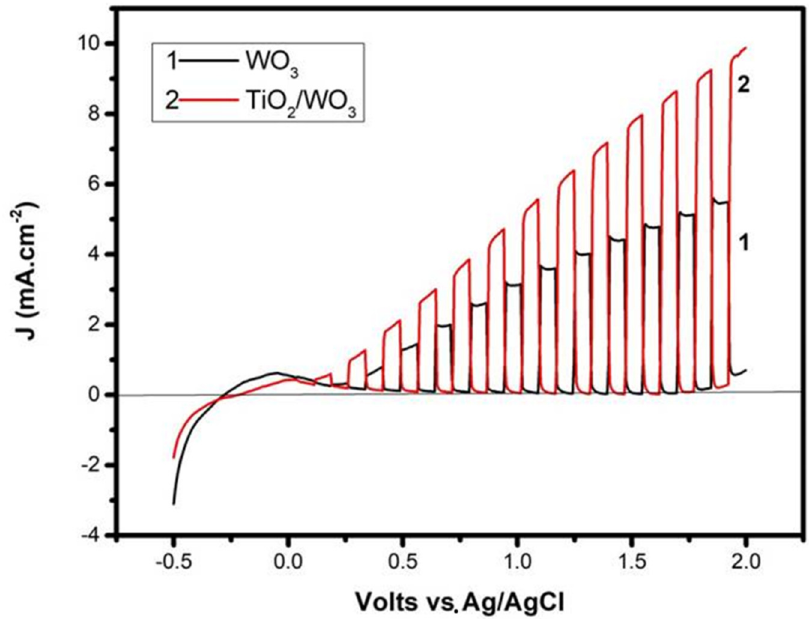
Figure 4. Current density-voltage curves for a photoelectrocatalytic cell made of two different photoanodes. Recording was done in light chopping mode demonstrating the voltage range of the pure photocurrent.